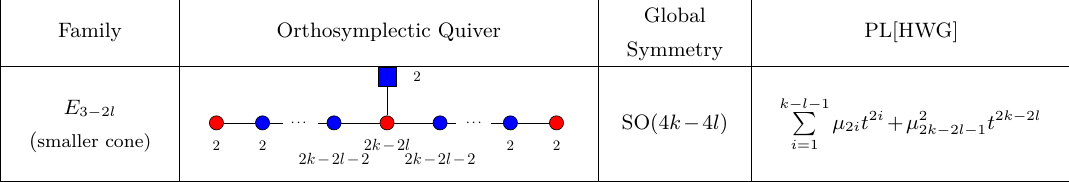
Table 16. The smaller cone of the E 3 − 2 l family along with the global symmetry and HWG. The HWG contains the spinor fugacity µ 2 k − 2 l − 1 because the larger cone in table 15 contains the other spinor fugacity µ 2 k − 2 l . This originates from the finite coupling case where the two cones are the same, but the HWG for each of them carries one of the two spinor fugacities. Their union then contains both spinors fugacities and the intersection contains neither spinors.